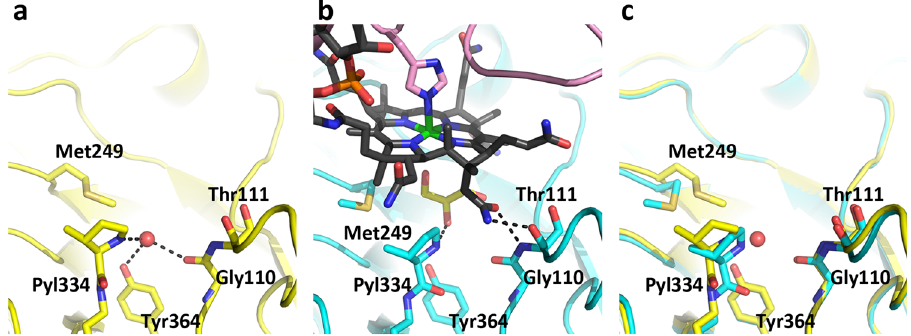
Fig. 4 Residues around the pyrrolysine active site change their orientation upon MttC binding. View of the active site of ( a ) MttB (yellow), ( b ) MttB- MttC complex (cyan), and ( c ) their superposition. MttB is shown as ribbon, with Gly110, Thr111, Met249, Pyl334 and Tyr364 shown in stick. Notable changes are (1) the water, shown as a red sphere, which hydrogen bonds to pyrrolysine in isolated MttB is absent in the MttB-MttC complex, (2) the side chain of Met249 moves away from where TMA would be positioned upon addition to pyrrolysine, and (3) a solvent molecule (glycerol) binds to the pocket formed between MttB and the β -face of the corrinoid cofactor.